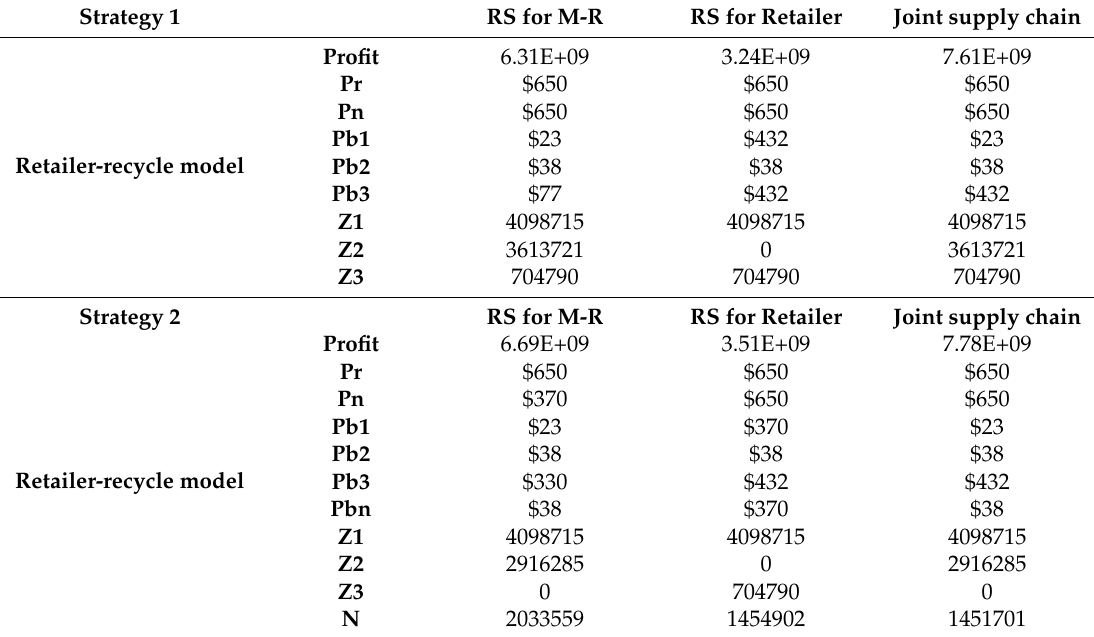
Table 7. Retailer-recycle model for two acquisition